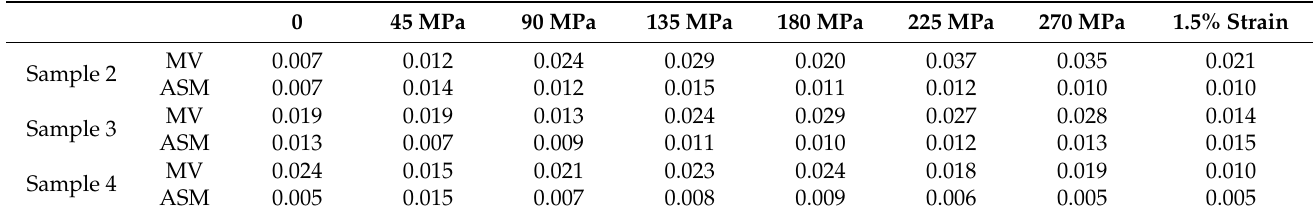
Table 2. Comparative results of the repeatability of RMF in different